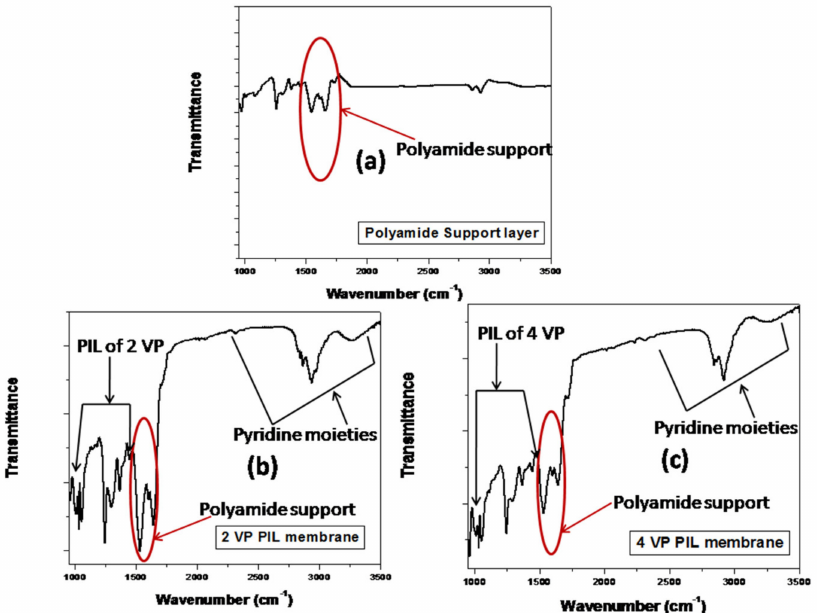
Figure 6. FTIR spectra for polyamide support membrane ( a ) and PIL augmented membranes ( b , c